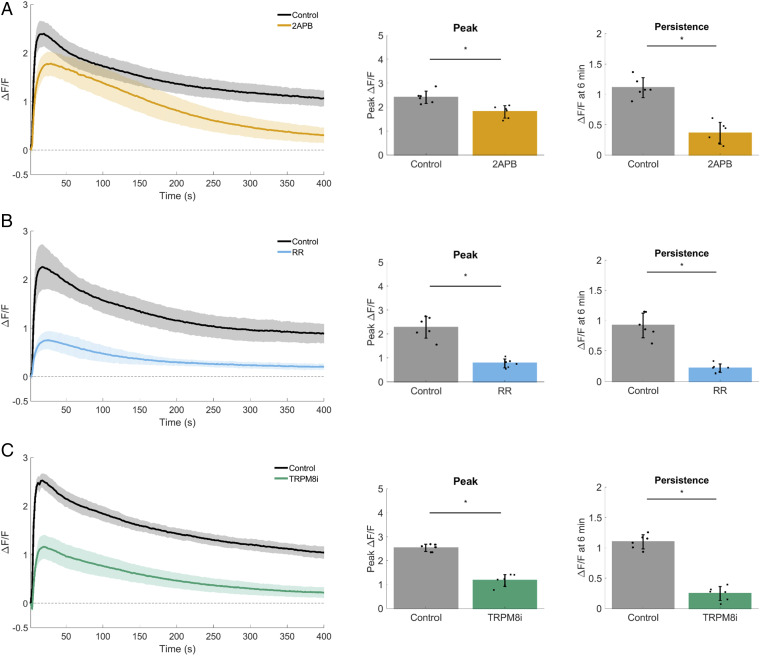
TRPM8 is necessary for mechanically stimulated calcium signaling. For each dataset, traces show mechanically stimulated calcium signaling (ΔF/F) plotted over time for control and treated cells. Bar graphs show quantification of peak ΔF/F and ΔF/F at 6 min (persistence). (A) 2-Aminoethoxydiphenylborane (2-APB) inhibits store operated calcium release (SOCE) and inositol 1,4,5-trisphosphate (IP3) receptors, but can also act as a nonspecific TRP channel blocker. Treatment with 2-APB (200 µM) resulted in a significant reduction of peak ΔF/F, with the largest inhibition seen in ΔF/F at 6 min. (B) Ruthenium Red (RR) (30 µM) is also a nonselective TRP channel blocker. RR inhibited both peak ΔF/F and ΔF/F at 6 min compared with control. (C) RQ-00203078 is a potent and selective transient receptor potential cation channel subfamily M member 8 (TRPM8) antagonist (TRPM8i). RQ-00203078 (25 µM) inhibited both peak ΔF/F and ΔF/F at 6 min compared with control. Data are presented as mean ± SD. The asterisk (*) indicates significance from control, P < 0.05 via paired t test. Data represent n = 6 in total from six independent experiments for each group. Control groups were collected separately for each dataset.